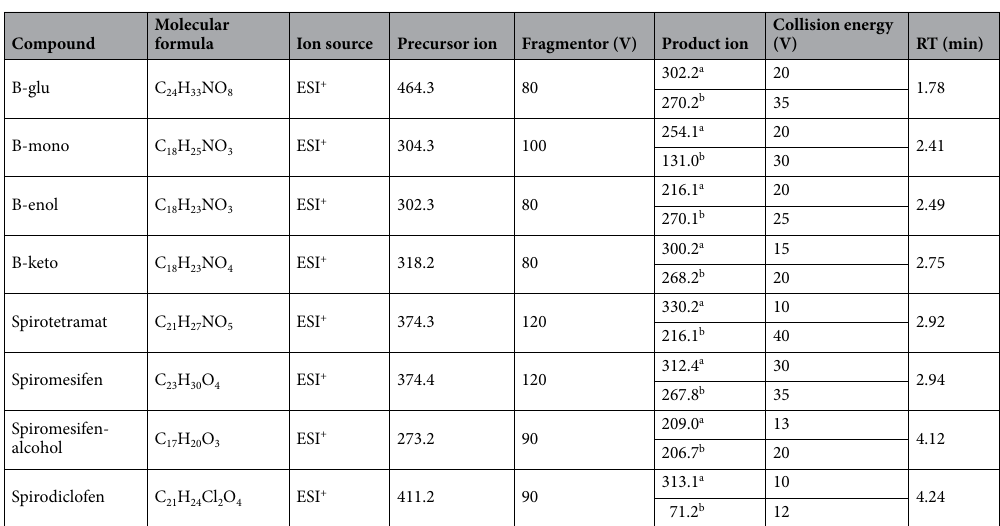
Table 1. Molecular formula and analytical conditions of the target compounds. a Quantifier. b Qualifier.